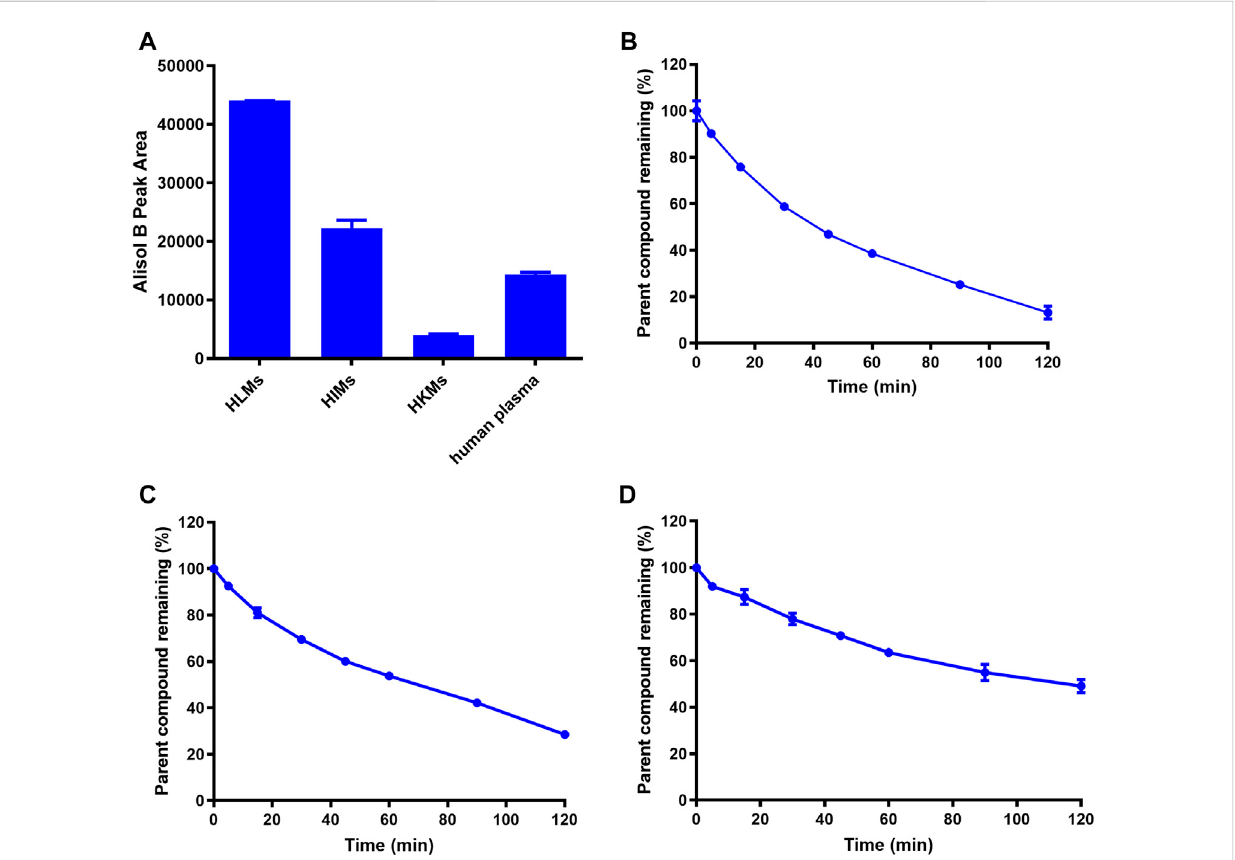
Themetabolic organs (A) andhydrolytichalf-lives(t 1/2 )ofAB23AinHLMs (B) ,HIMs (C) ,humanplasma(25%dilution) (D) .Thedatawereexpressedas mean ± SD.